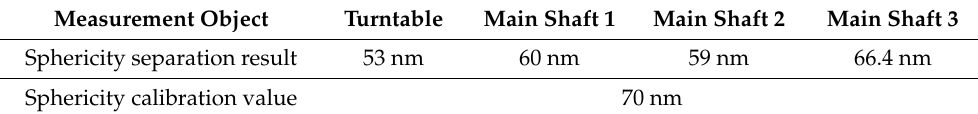
Table 2. Standard sphericity separation error (standard sphere b) (nm).